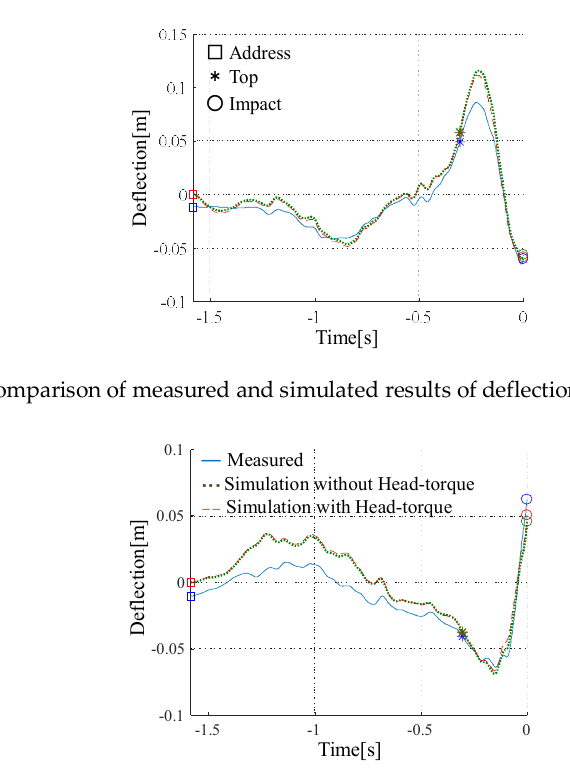
Figure 10. Comparison of measured and simulated results of deflection in the face direction. Table 1. Difference between measured and simulated results of club shaft